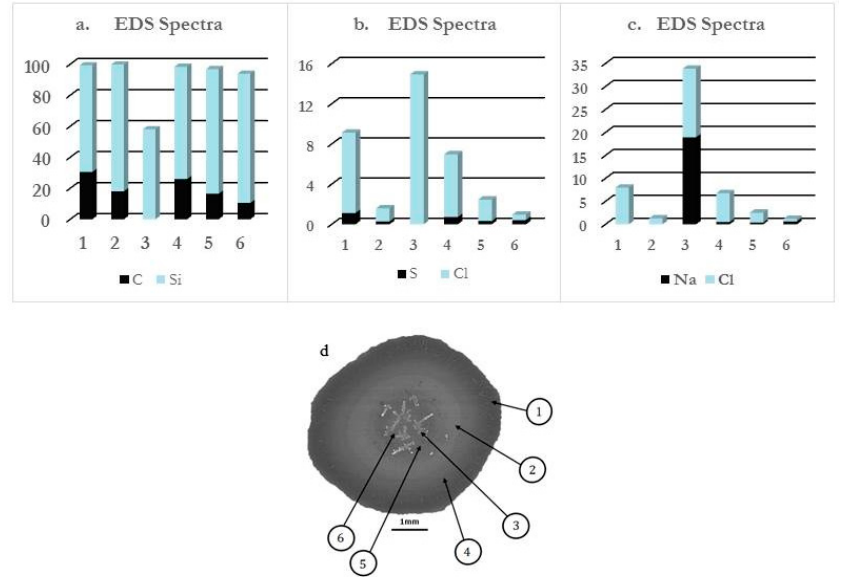
Figure 4. ( a – c ) EDS spectra showing the relative amounts of C, Si, S, Cl, and Na on 6 different spots of a deposit of PDADMAC-SLES mixture on a silica wafer. ( d ) SEM image of the deposit showing the 6 different spots. NB: spot 3 indicates the penetration of the EDS beam through the salt crystal.